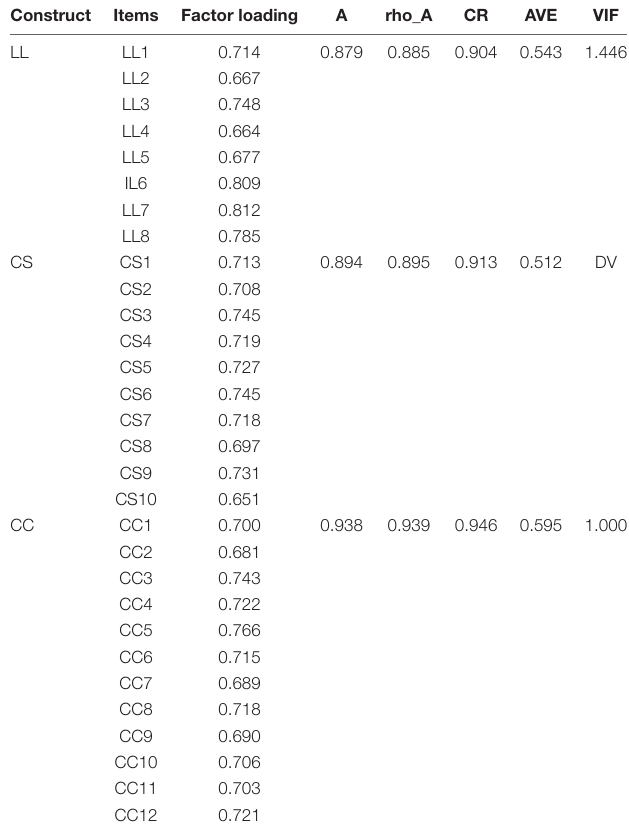
TABLE 1 | Confirmatory factor analysis.